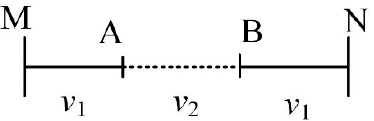
Figure 13. Hybrid structure of the overhead lines and a cable.